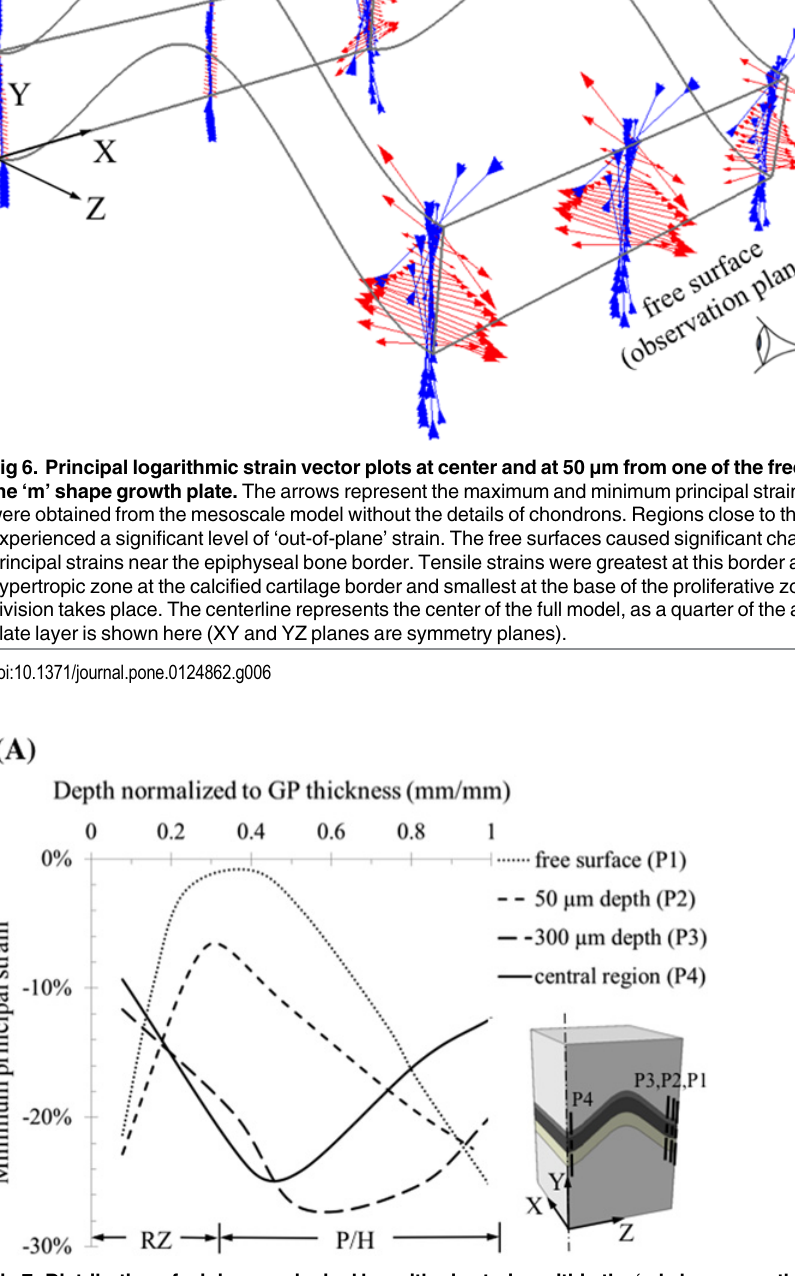
Fig 7. Distribution of minimum principal logarithmic strains within the ‘ m ’ shape growth plate obtained from the mesoscale model without cellular detail. Peak compressive strains occurred at the base of the proliferative zone where cell mitosis occurs. This contrasts with regions close to the free surface, where compressive strains were at a minimum around the base of the proliferative zone and maximum in the reserve and hypertrophic